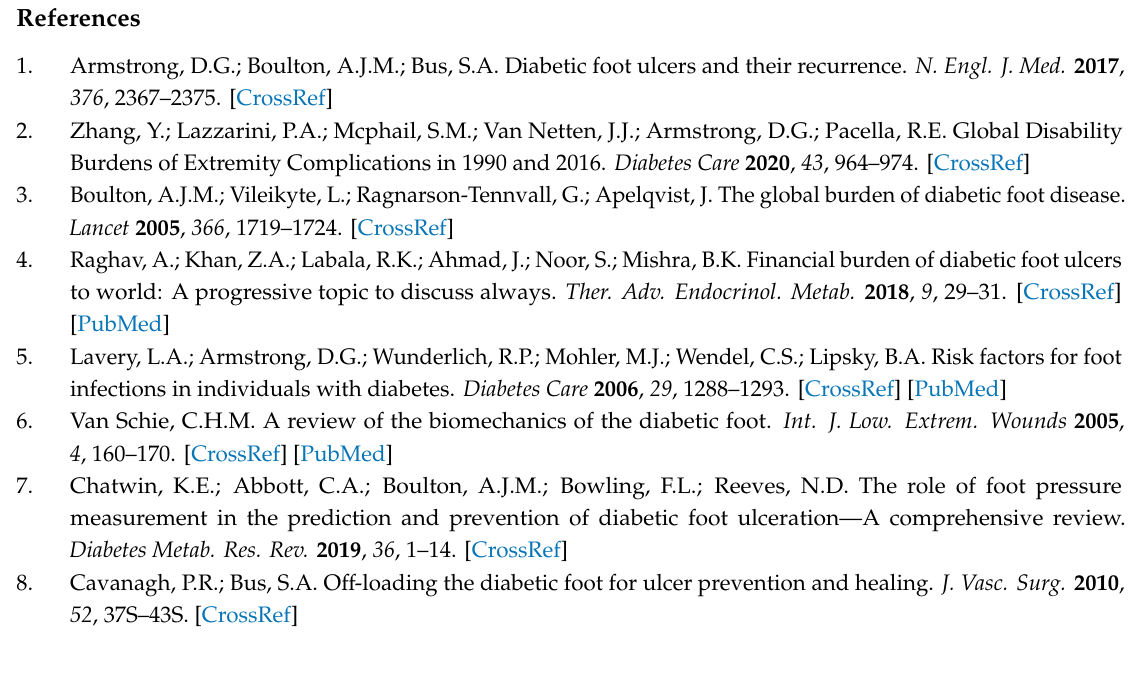
Table S1. Risk of bias assessment: QUIPS tool, Table S2. Risk of bias assessment: 21-item score, Table S3. Risk of bias assessment: SIGN, Table S4. Plantar pressure-ulcer development, Table S5. Weight-bearing activity-ulcer development, Table S8. Plantar pressure-ulcer healing, Table S9. Weight-bearing activity-ulcer healing, Table S10. Device adherence-ulcer healing, Table S11. Cumulative plantar tissue stress-ulcer healing, Supplementary file S1. Validation Sets, Supplementary file S2. Search